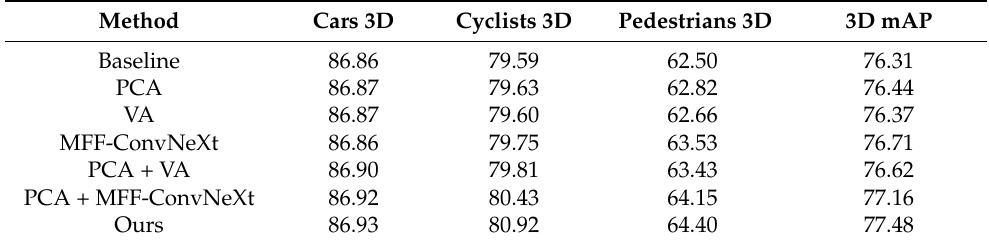
Table 3. Performance of the proposed method with different configurations on the KITTI validation set. The results are evaluated with the mAP calculated by 40 recall positions for all classes.